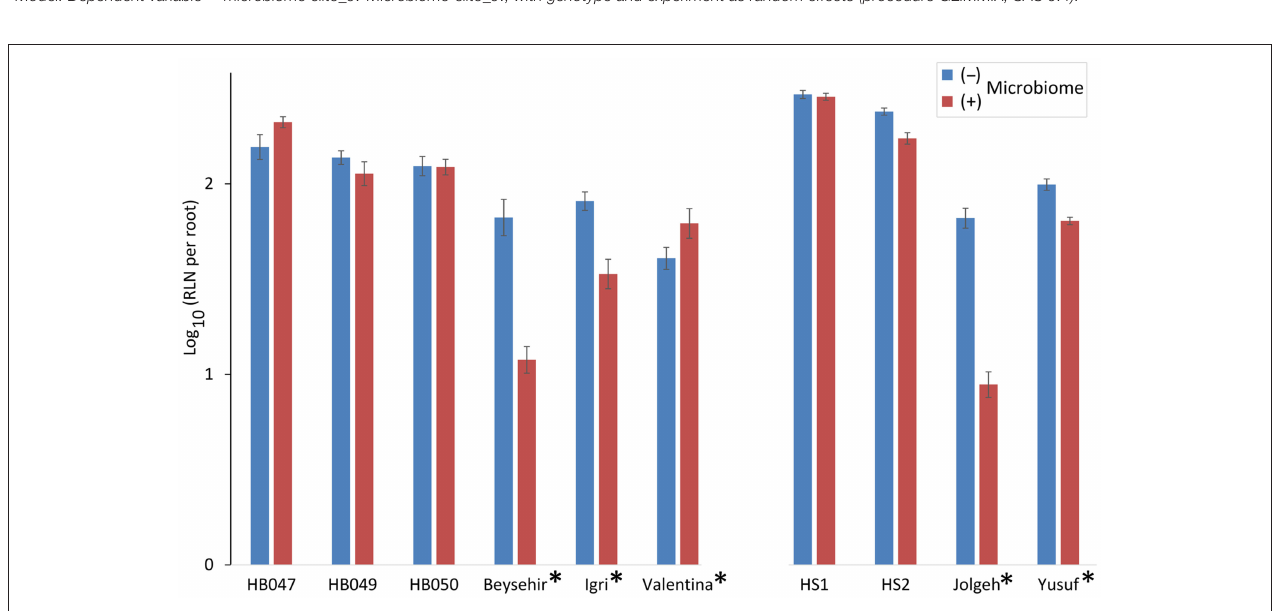
FIGURE 2 | Responsiveness of elite cultivars (indicated by a star) and ancestral genotypes of barley to rhizosphere microbiomes regarding the invasion of root-lesion nematodes (RLN) within 2 weeks. Mean log-transformed numbers of RLN per root system from the two independent experiments are separated on the horizontal axis. Error bars indicate SE ( n = 12 plants with ( + ) and 12 plants without (–) inoculated microbiome per genotype of